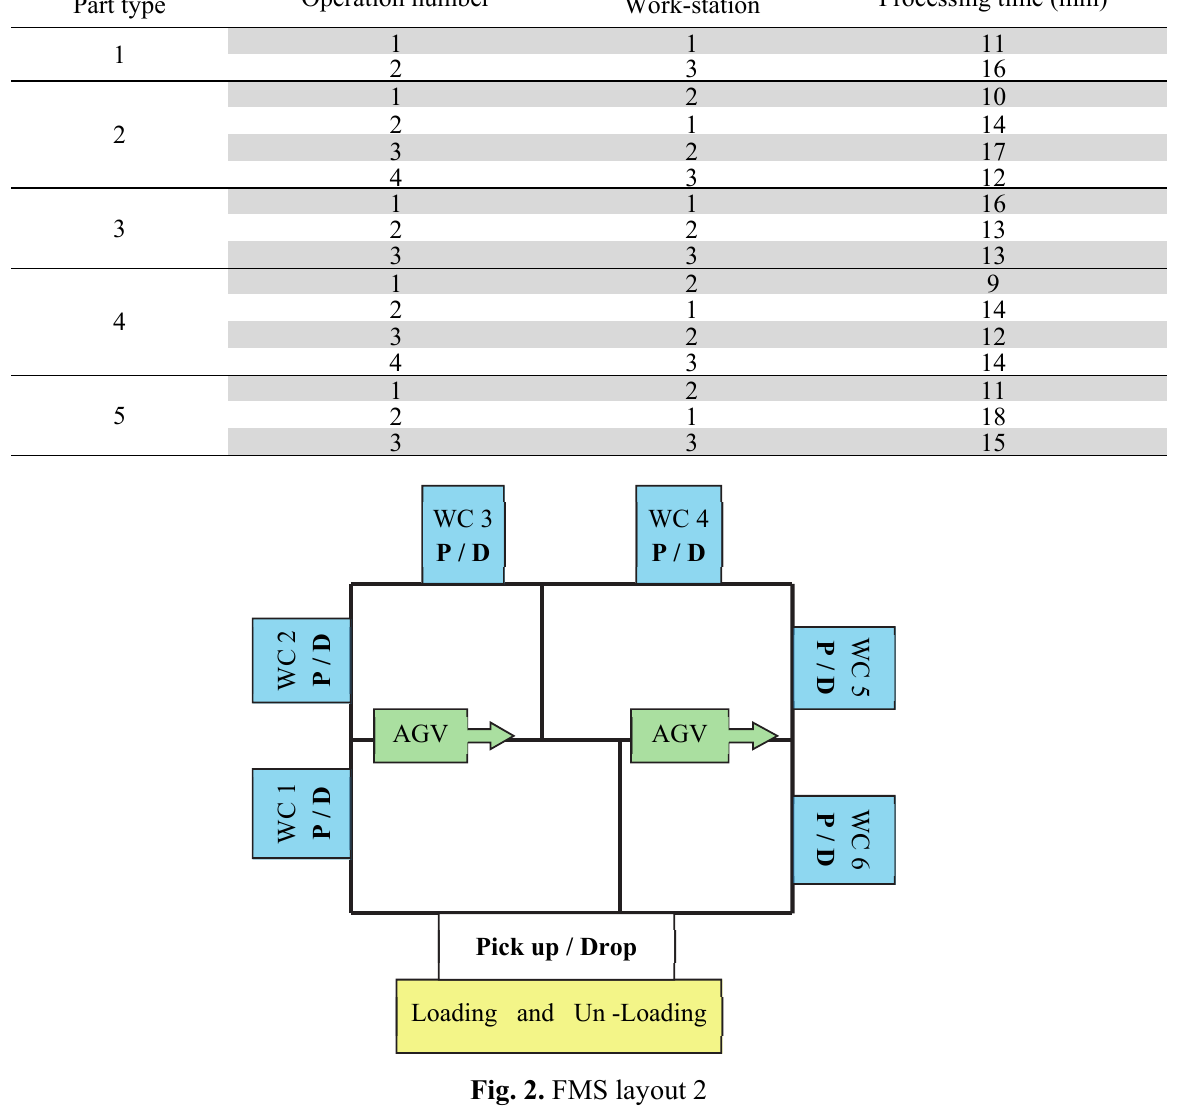
Part type routing and manufacturing characteristics for the FMS layout 1 Part type Operation number